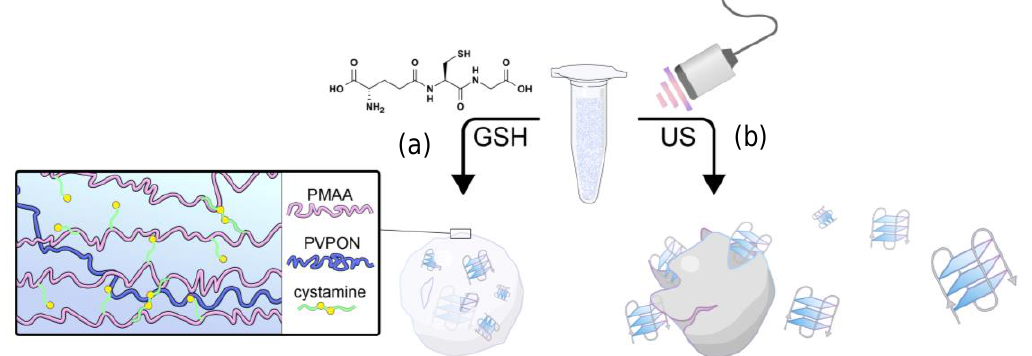
Figure 6. Release of DNA from (PMAA/PVPON) 6 hydrogel capsules via ( a ) GSH-treatment and ( b ) US irradiation. Capsules treated ( c ) with 5 mM GSH at 37 °C and ( d ) with US, were pelleted via centrifugation and the supernatant was removed for quantification via UV – Vis absorbance at 260 nm. For each marker, three aliquots were taken for measurement and averaged. Optical images of (PMAA/PVPON) 6 hydrogel capsules ( e ) before and ( f ) after US irradiation (14 W/cm 2 for 60 s in 20-s